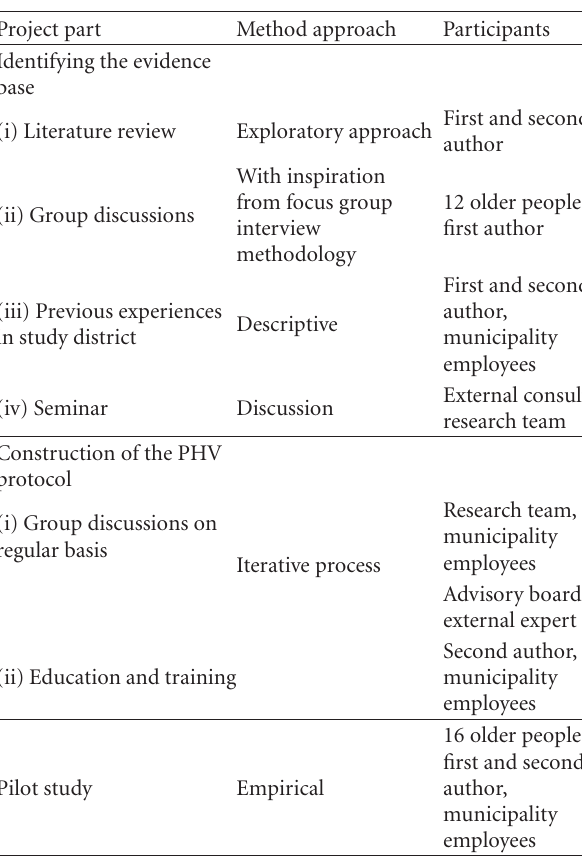
Table 1: Project